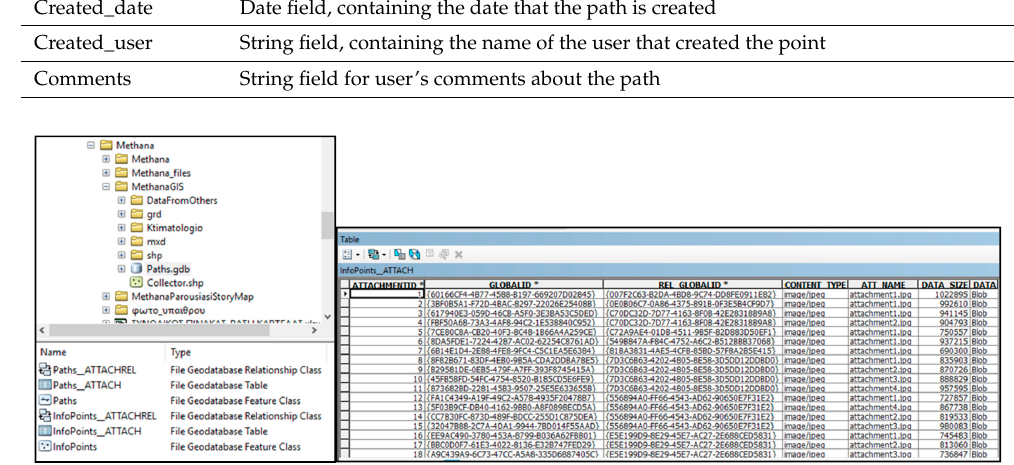
Figure 1. Screenshot showing the contents of the File Geodatabase which was created for field work (above left ) and the schema of the database associated with photos or videos collected during field work (above right ).